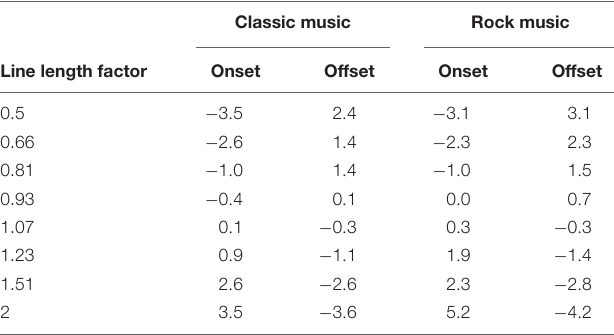
TABLE 4 | Adjustment in level [dB] to the onset and offset of the line length manipulations by music genre. Classic music Rock